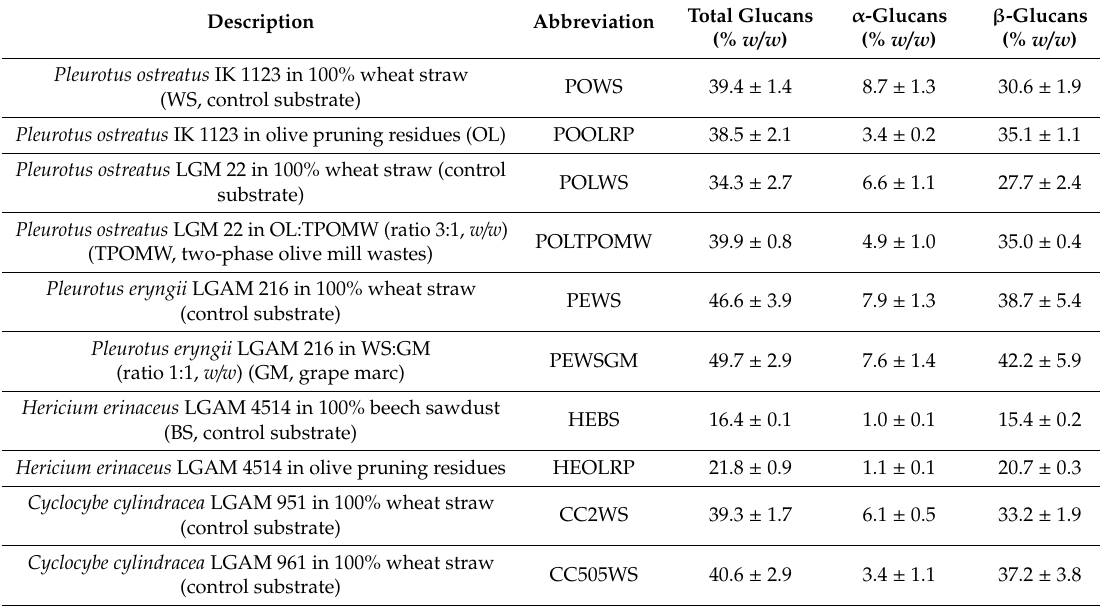
Table 1. Fungal strains, mushroom cultivation substrates and glucans content *.